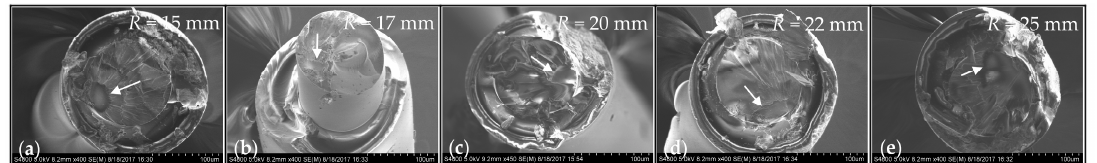
Figure 15. Fracture cross sections under different bending radii. ( a ) R = 15 mm; ( b ) R = 17 mm; ( c ) R = 20 mm; ( d ) R = 22 mm; ( e ) R = 25 mm.